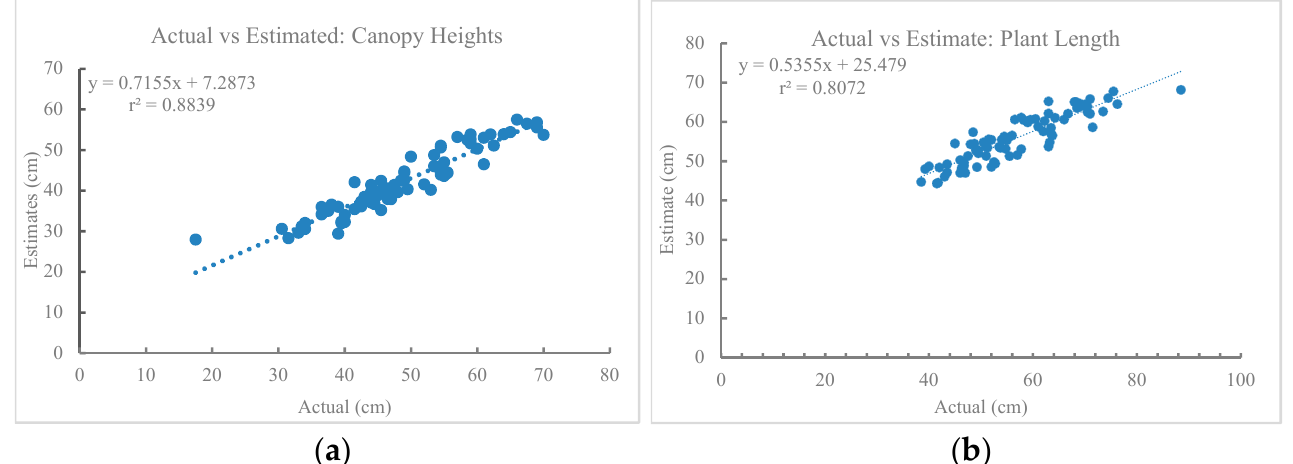
Figure 4. Validation of the image-derived heights to the ground measured heights in the testing datasets: ( a ) correlation between actual canopy heights and image-derived canopy heights taken on the same date; ( b ) correlation between actual plant heights and maximum heights.